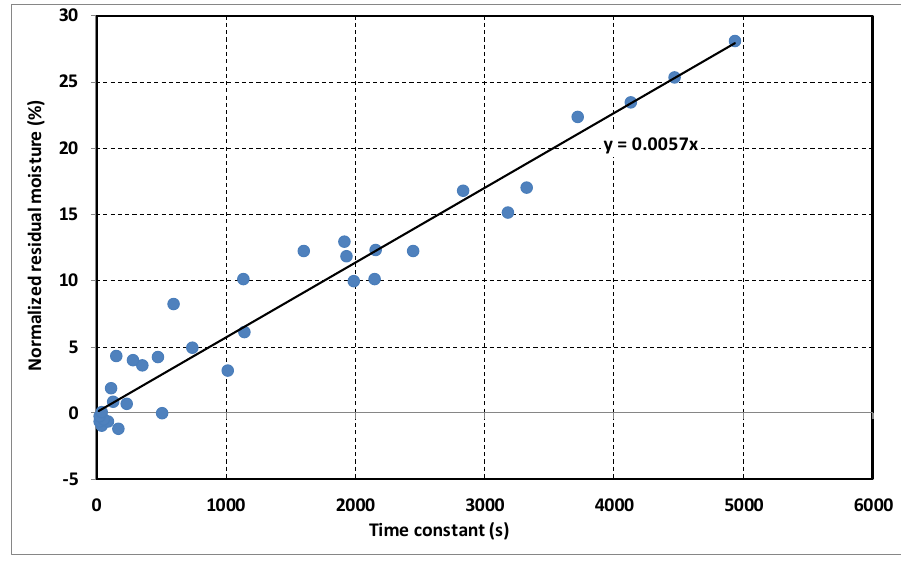
Figure 4. Impact of drying time constant on residual moisture.